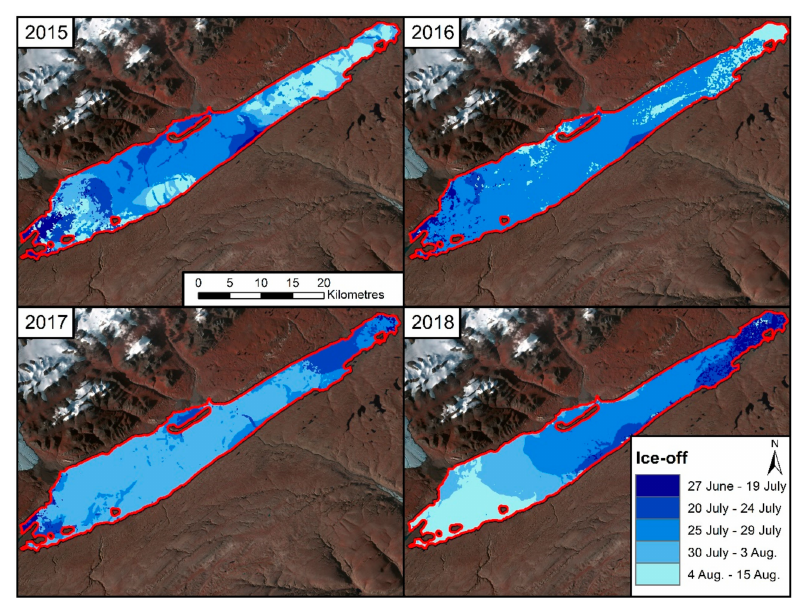
Figure 11. Ice-o ff dates for Lake Hazen, determined on a pixel by pixel basis using the Otsu method, from 2015–2018. Landsat-8 Level-1 image courtesy of the U.S. Geological Survey (Digital Object Identifier (DOI) number: / 10.5066 / F71835S6).